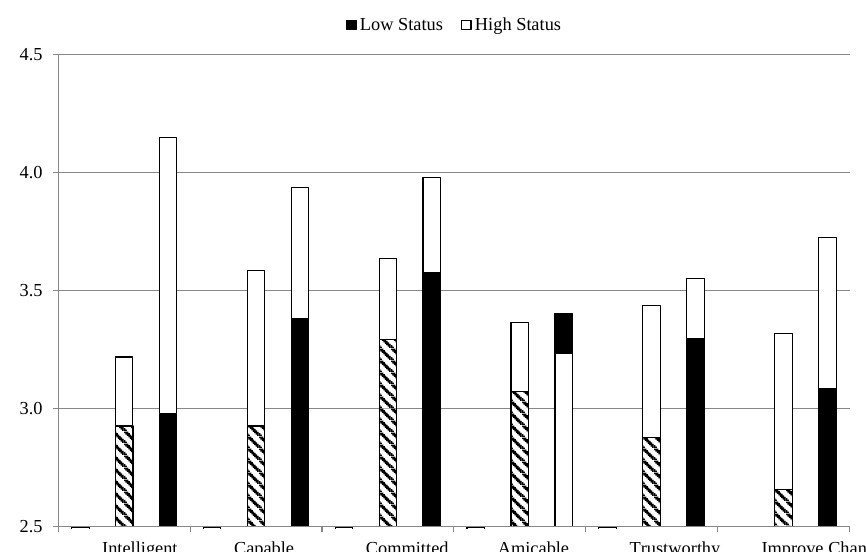
Note: The striped bars correspond to the mean for the low-status candidates in the choice status condition. The black bars refer to the low-status candidate in the education condition. The end of the white bar denotes the mean of the high-status candidate in each condition. All differences between the high and low candidate are significant at the 0.05 level (two-tailed tests) with the exception of the difference in amicability in the education condition. Here, the low-status candidate (high school diploma) is viewed as being more amicable than the high status candidate (MA) on average. Figure 3: Summary of perceptions of quality, study